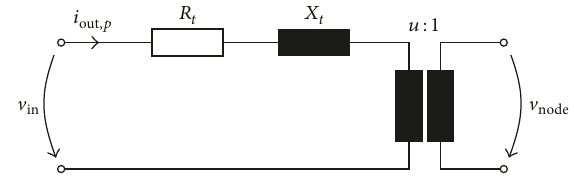
Figure 5: Single-phase reference circuit of a transformer.